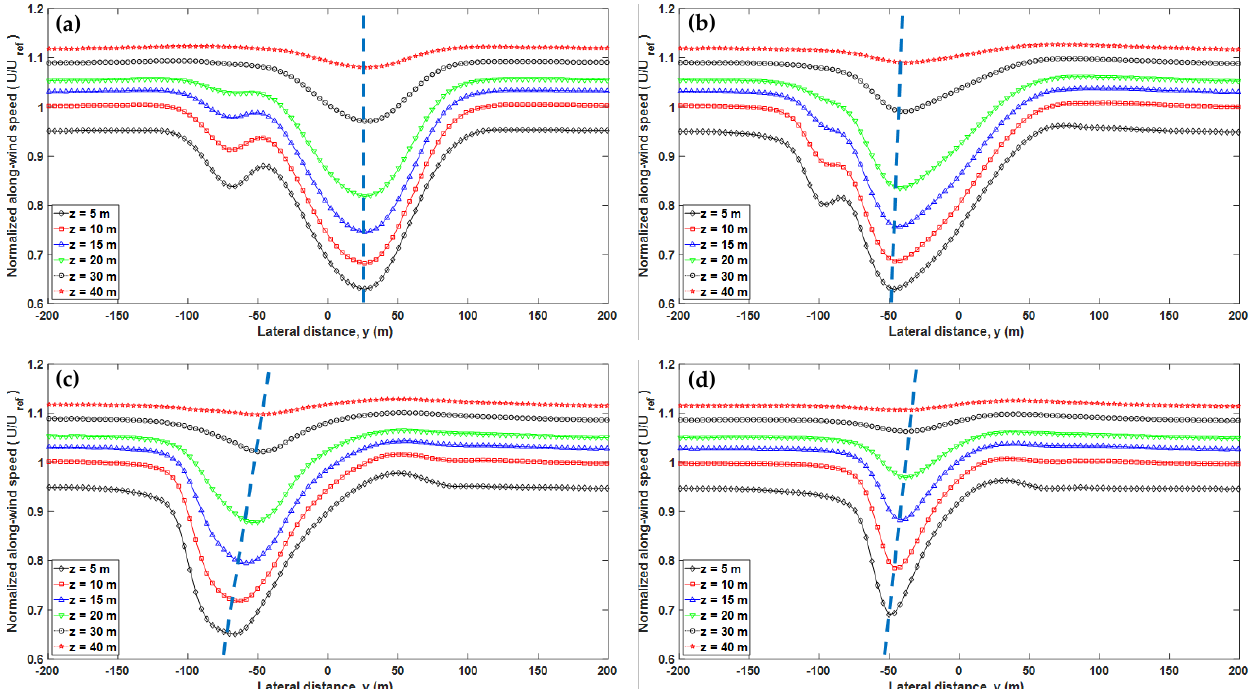
≈ 325 m: ( a ) 0 ◦ ; ( b ) 22.5 ◦ ; ( c ) 45 ◦ ; ( d ) 67.5 ◦ .